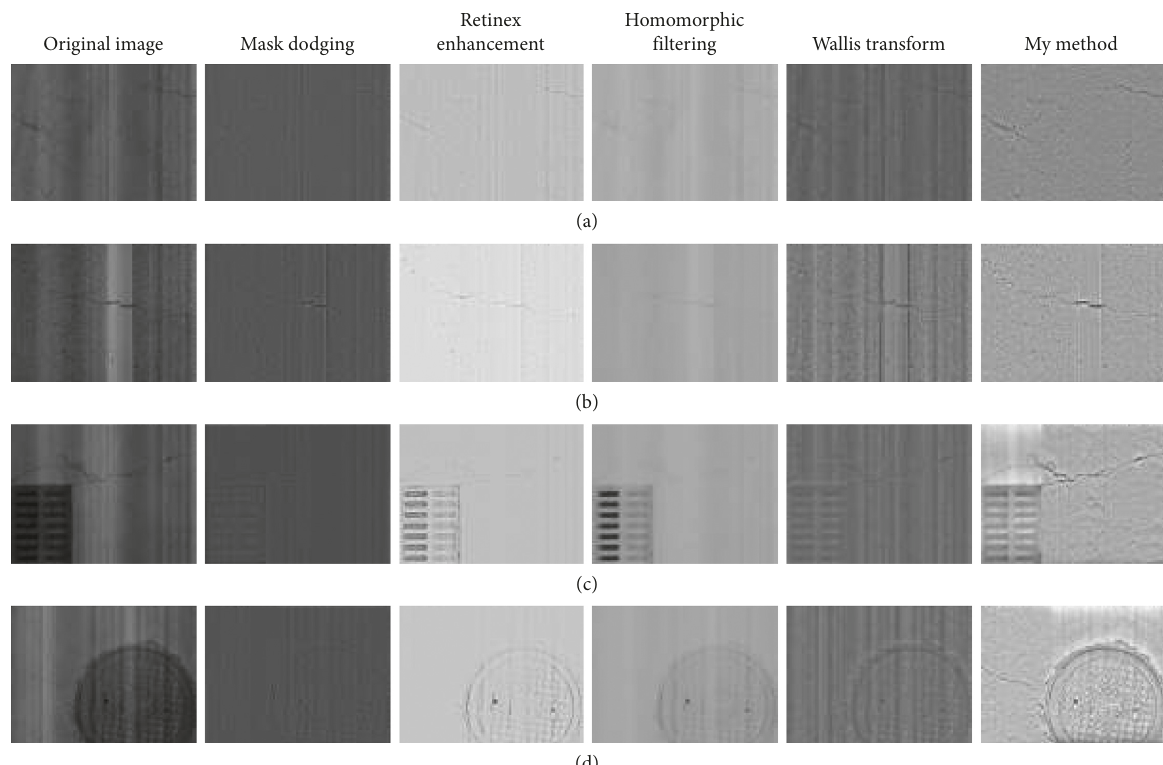
Figure 8: Comparison of different dodging methods for line array image of (a) single content pavement, (b) pavement with lane line, (c) pavement containing square manhole cover, (d) pavement containing round manhole Table 1: Quantitative evaluation parameters of the four images before and after dodging by different methods. Image